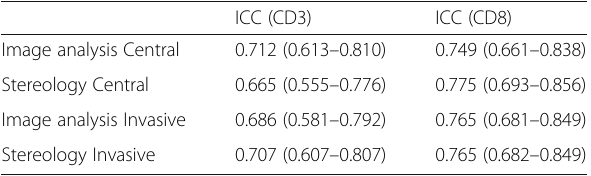
Table 6 Intra-class correlation coefficient for numerical density estimates